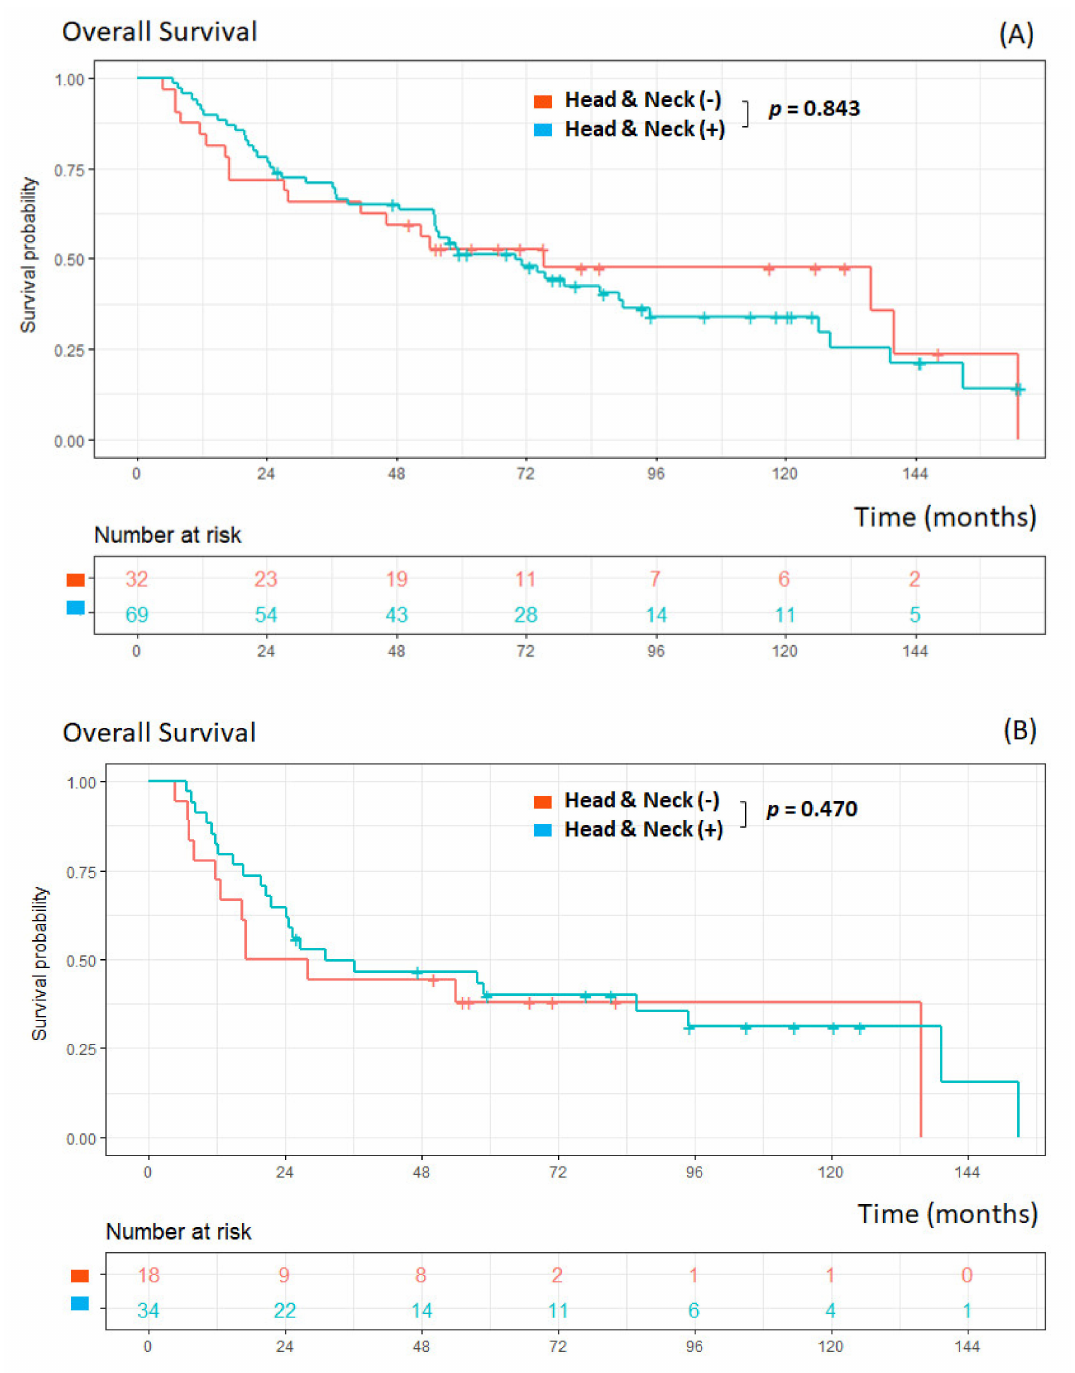
Figure 3. Kaplan–Meier curves with or without head and neck cancer in all MPCs ( A ), in antecedent or synchronous MPCs ( B